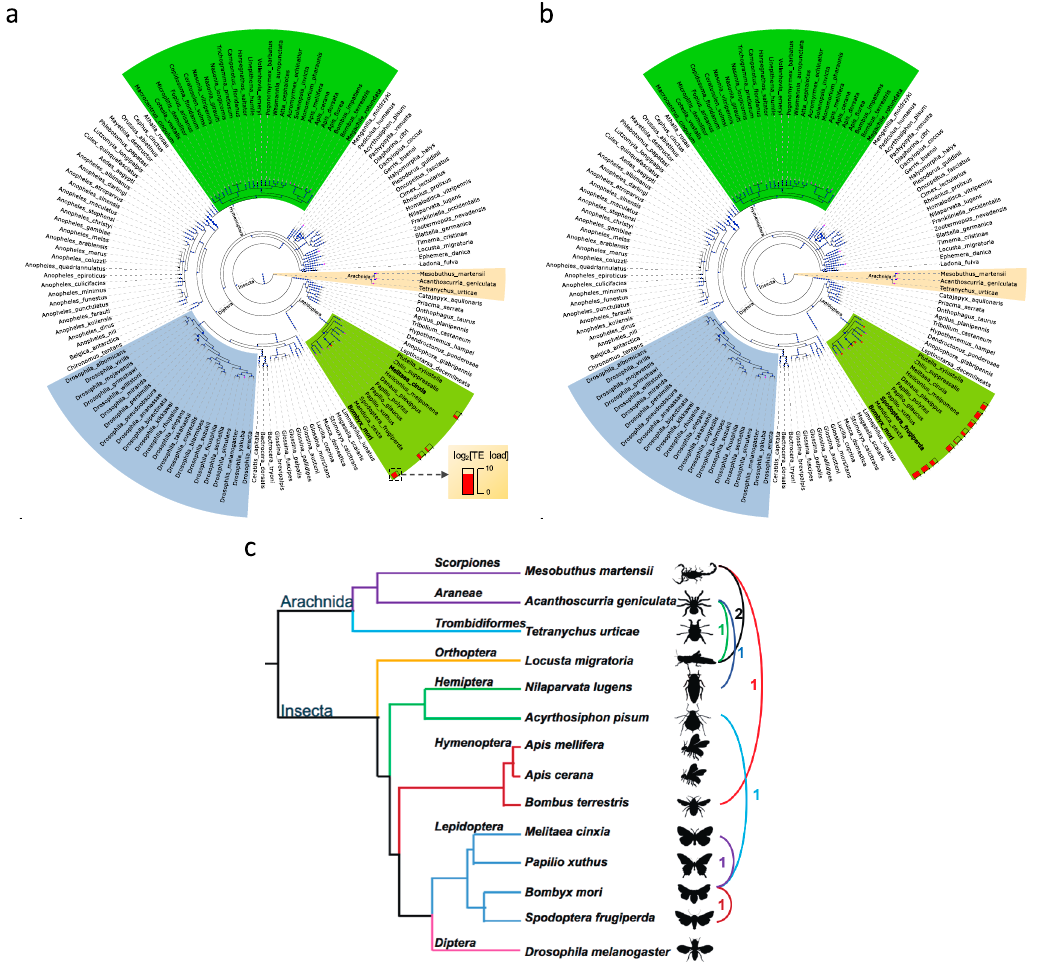
Figure 7. The HTTs in arthropods. ( a ) The HTT of Gypsy between M. cinxia and B. mori . ( b ) The HTT of Mariner between B. mori and S. frugiperda . The species names of hosts of HTT are in bold. ( c ) Eight HTTs in the fourteen